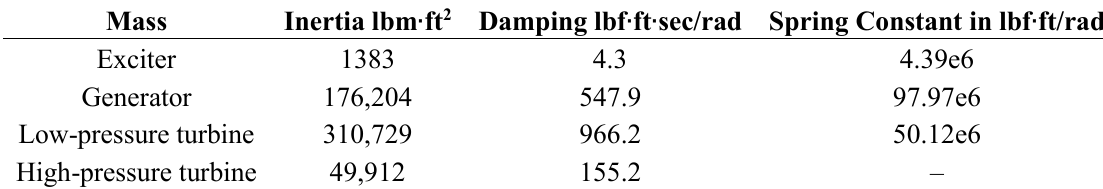
Table 1. Mechanical data for Generator A.